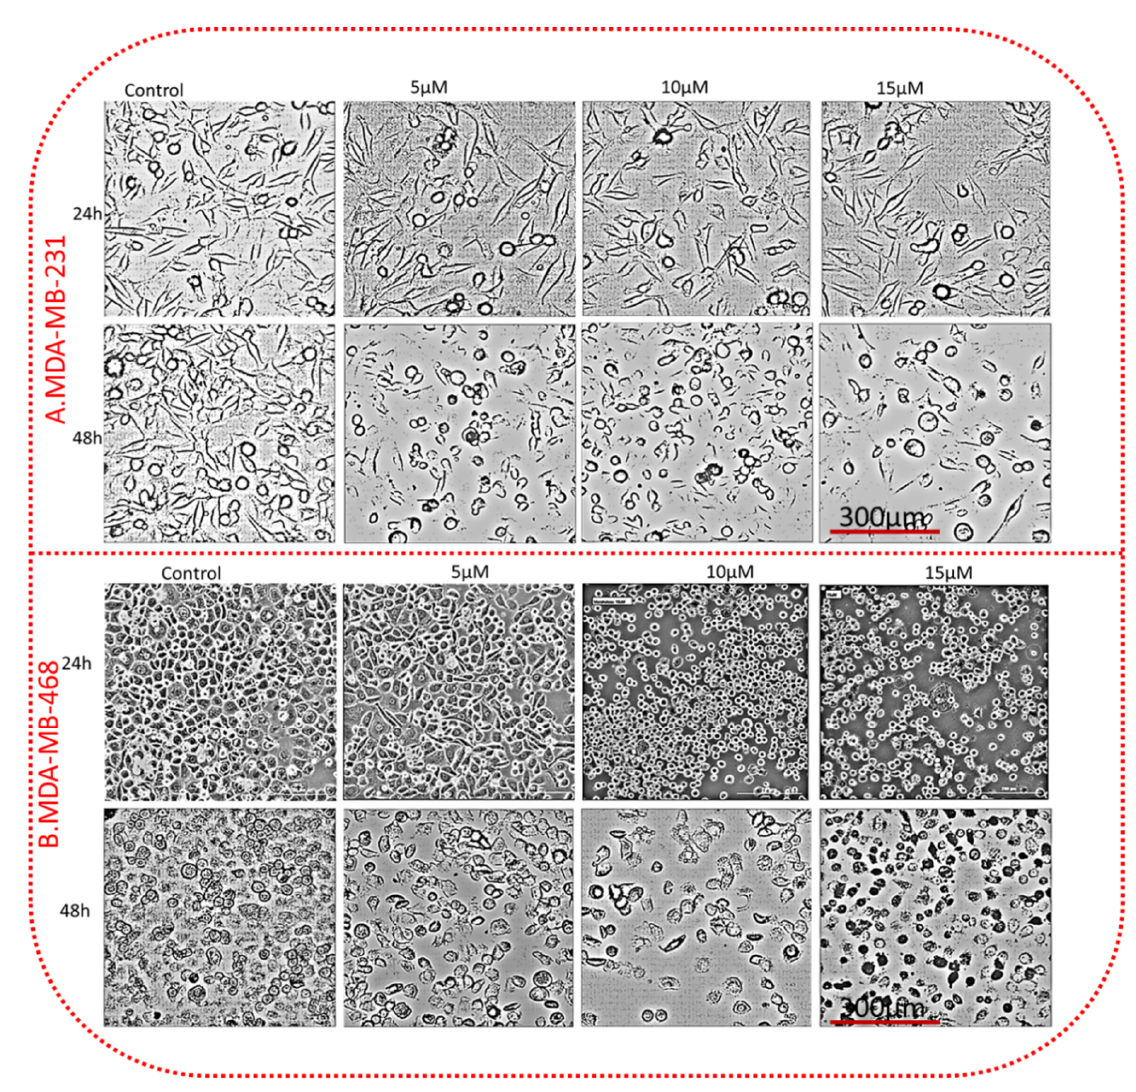
Figure 3. TQ alters the morphology of TNBC cells. Both cell lines were treated with 5, 10, and 15 µM TQ and control (only media with DMSO) for 24 h. The morphological changes in TQ-treated TNBC cells were visualized by a Cytation5 cell Imaging reader (BioTek Instruments, Inc., Winooski, VT, USA) using a phase-contrast digital microscope. Images represent MDA-MB-231 ( A ) and MDA-MB-468 ( B ). The treated cells showed irregular aggregates cells, small and round cells, apoptotic cells, and decreased cell density relative to control. All scale bars indicate 300 µm in 40× magnification.